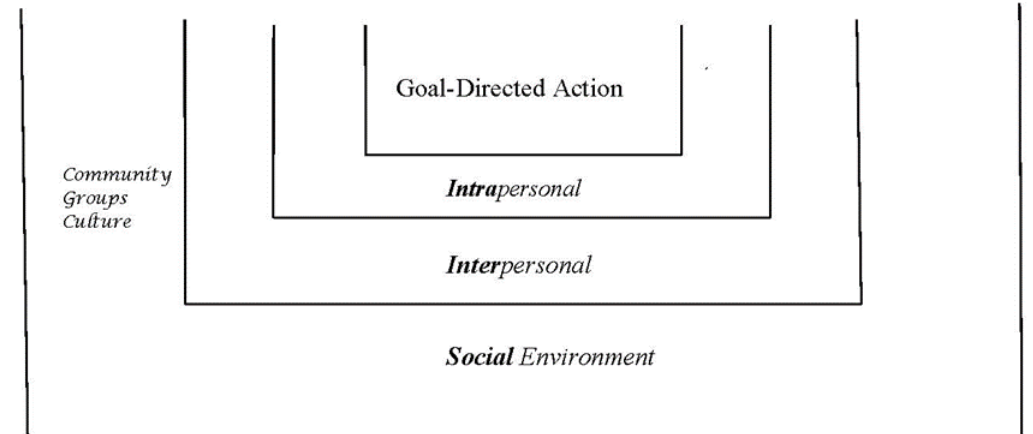
Figure 1. Three contexts of obstacles within which people practice their goal-directed adaptive actions. The obstacle, trauma, challenge become the ‘stage’ or backdrop for goal-directed action that is played out on stage. Experiences of engagement as in interest, curiosity, appreciation or of social relatedness as in empathy, compassion, helping are enacted on these stages where obstacles are the backdrop or scenery and not the main